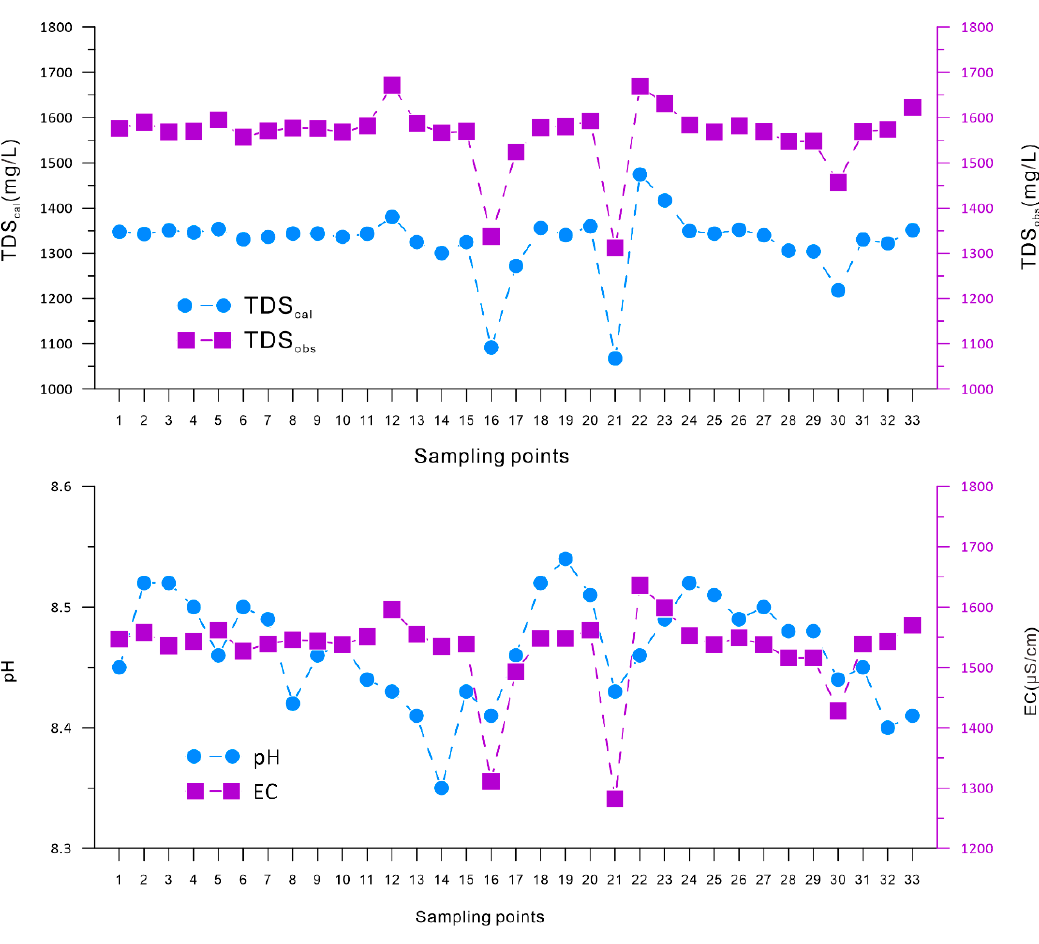
Figure 2. The values of pH, electrical conductivity (EC), observed values of total dissolved solids (TDS obs ) and calculated values of total dissolved solids (TDS cal ) for Bosten Lake waters at different sampling points. Table 1. Descriptive statistics and normality test (Kolmogorov–Smirnov) of the hydrochemical parameters of Bosten Lake (n = 33).